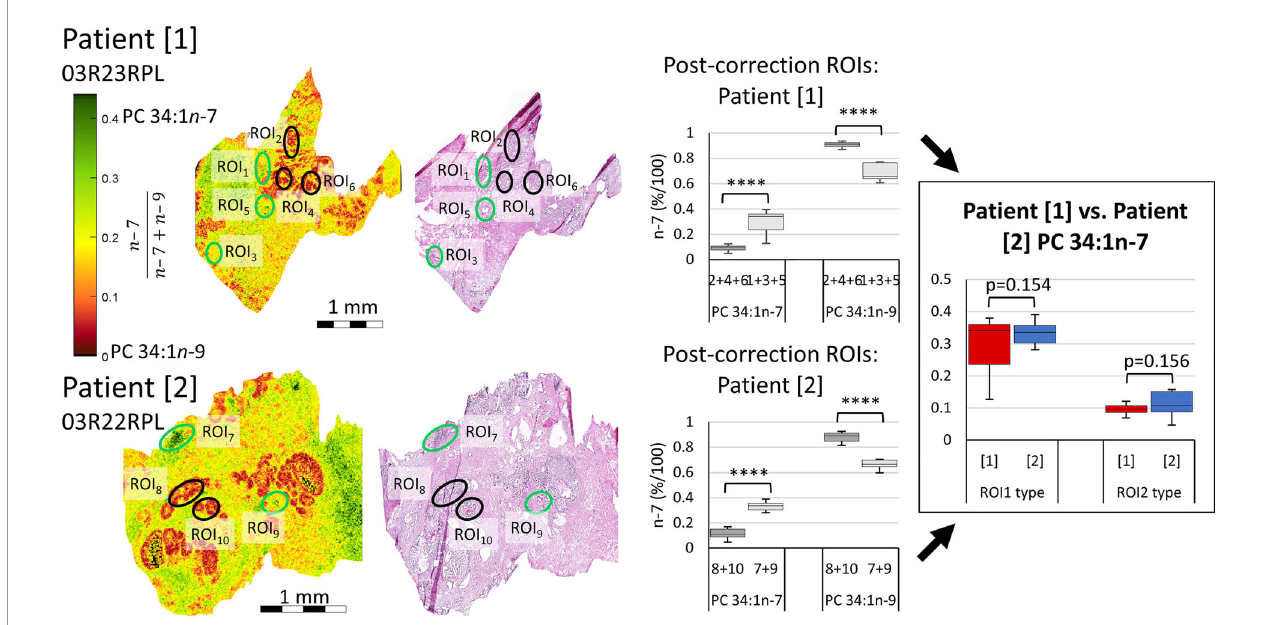
FIGURE 5 | Comparison of isomer resolved lipidomics between two patient tissue samples. Isomer FDI (far-left) and H&E (mid-left) images showing correlation between tissue features and isomer distribution for two patient samples. FDI color scale bar ranges from 0.0-0.45 n -7 intensity to assist visual distinction and are based off biologically relevant abundances. ROI 1 type tissues, containing a higher relative abundance of PC 34:1 n -7, are indicated as green ellipses, while ROI 2 type tissues, containing a higher relative abundance of PC 34:1 n -9, are indicated in black. Product ion signal from the ROIs of either patient sample were corrected to mol%, grouped by ROI 1 and ROI 2 type similarity and compared intra-patient using a paired two-tailed Welsh ’ s t -test (mid-right). Patient samples were then compared inter- patient using a paired two-tailed t -test (far-right). (****p ≤